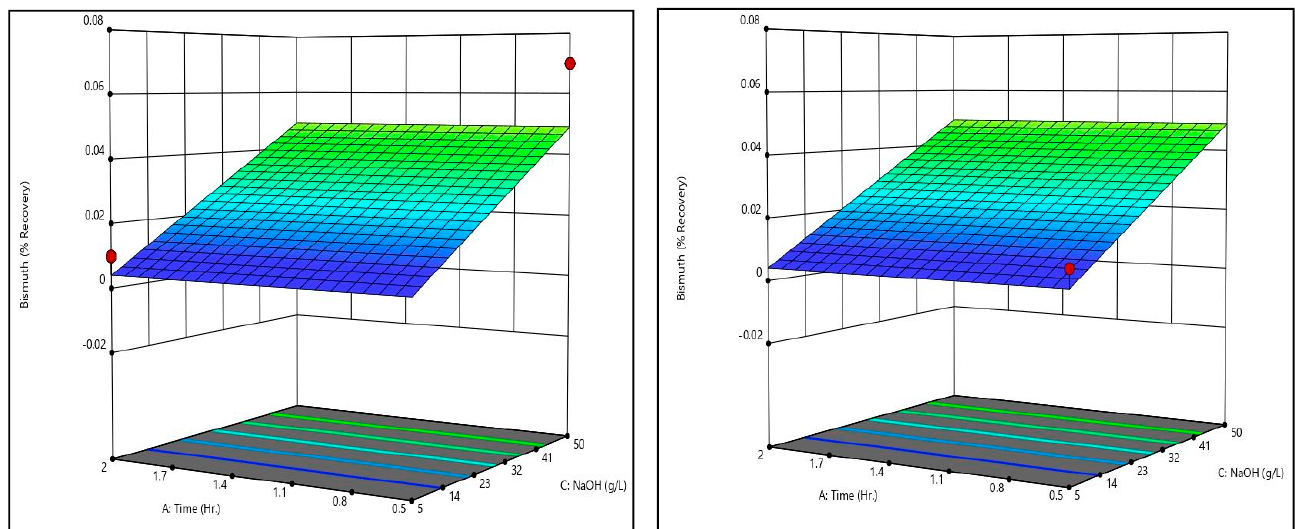
Figure 8. Caustic leaching bismuth recovery response surfaces: low temperature ( left ) and high temperature ( right ).